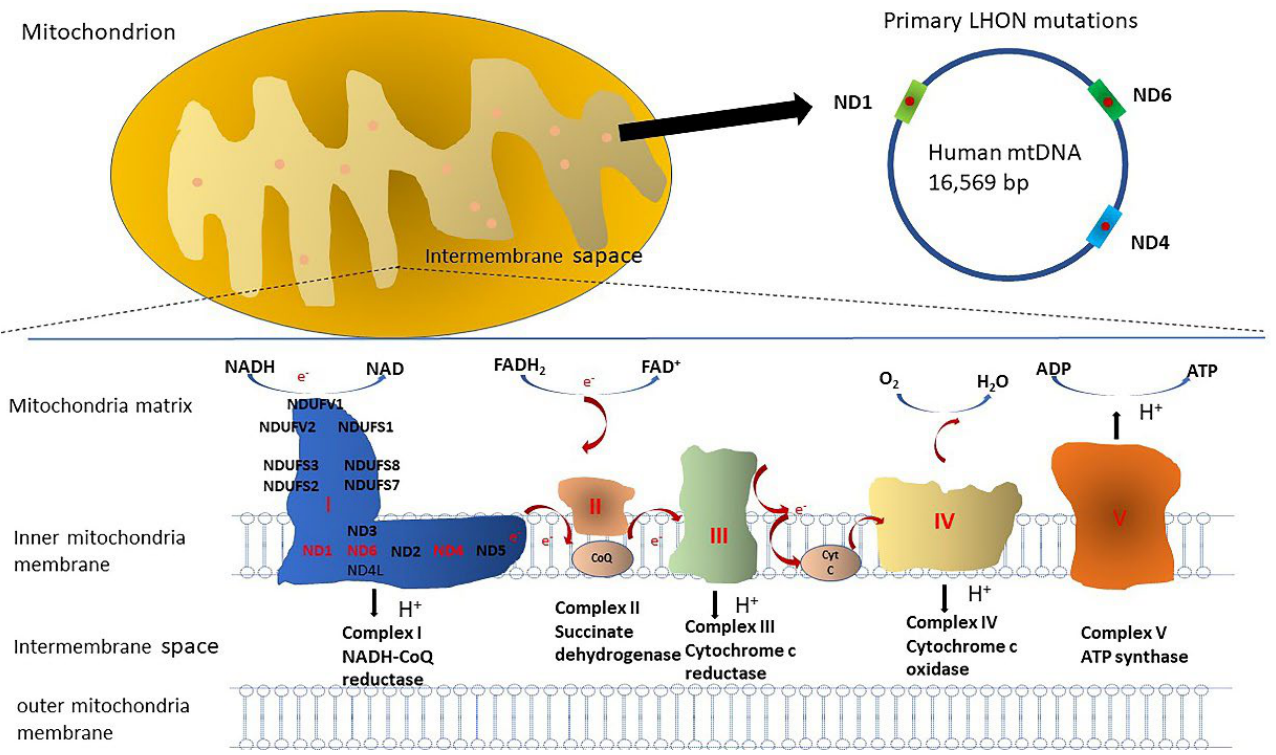
Figure 1. The diagram represents the electron transport chain and the three common primary mutations at mitochondrial nucleotide positions 3460, 11,778, and 14,484. The mutations affect ND1, ND4, and ND6 subunit genes of complex I, respectively.